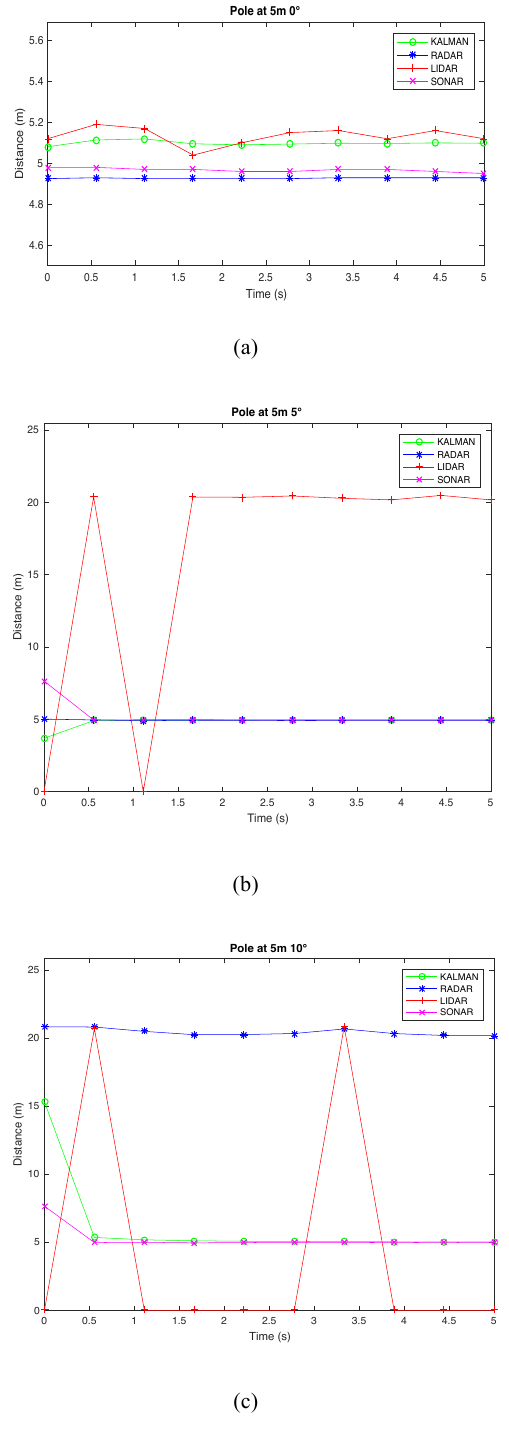
Figure 14 Pole at 5m distance, (a) 0°, (b) 5°, (c) 10° angle